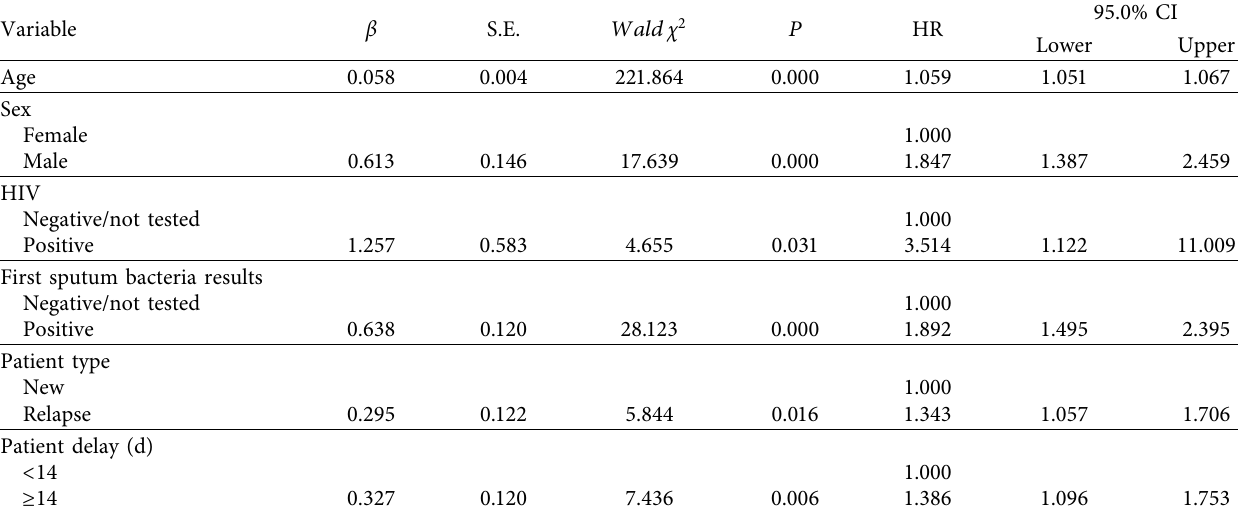
Figure 2: Graphs of the scaled Schoenfeld residuals and their loess smooth curves for the covariates: age of patients. Table 3: Results of multivariate analysis with a Cox proportional hazard model of risk factors for death during the treatment period in 7,032 tuberculosis